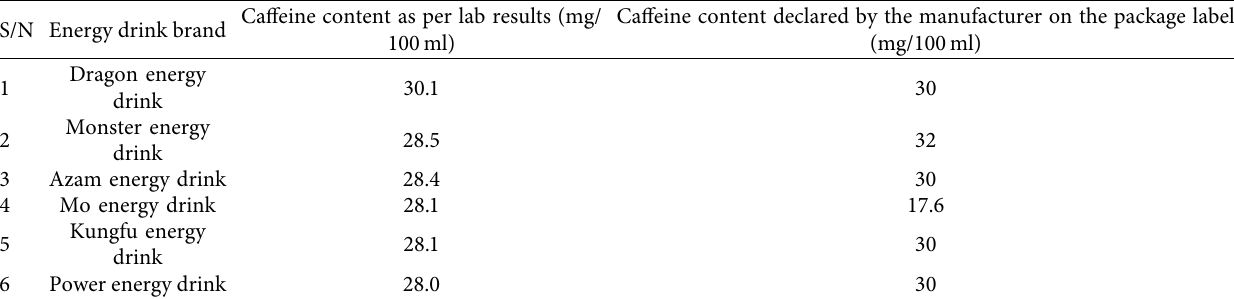
Table 5: Laboratory results for the cafeine content of the beverage samples and the published cafeine content according to the man- ufacturer’s package label Morogoro municipality, Morogoro, Tanzania, 2018-2019. Cafeine content as per lab results (mg/ Cafeine content declared by the manufacturer on the package label S/N Energy drink brand 100ml) (mg/100